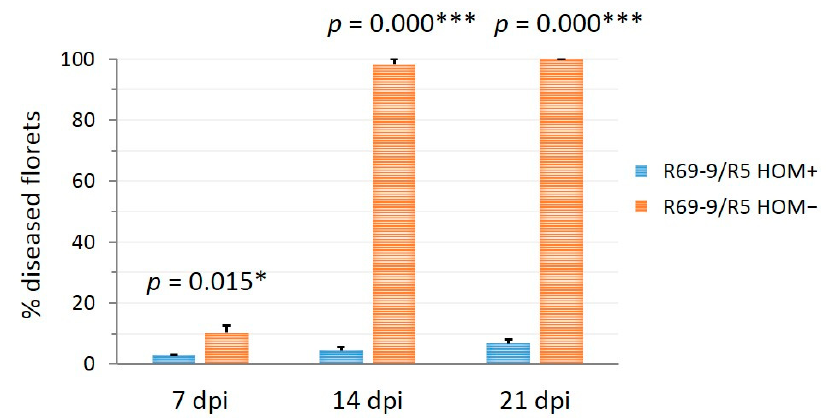
Figure 3. Evaluation of FHB symptom development following Fg inoculation in durum wheat HOM+ and HOM − lines for the Fhb7E locus. Data at all time points were subjected to Student ʹ s t -tests, and signi fi cant probability ( p ) values are indicated by * <0.05 and *** <0.001, respectively (dpi, days post inoculation).